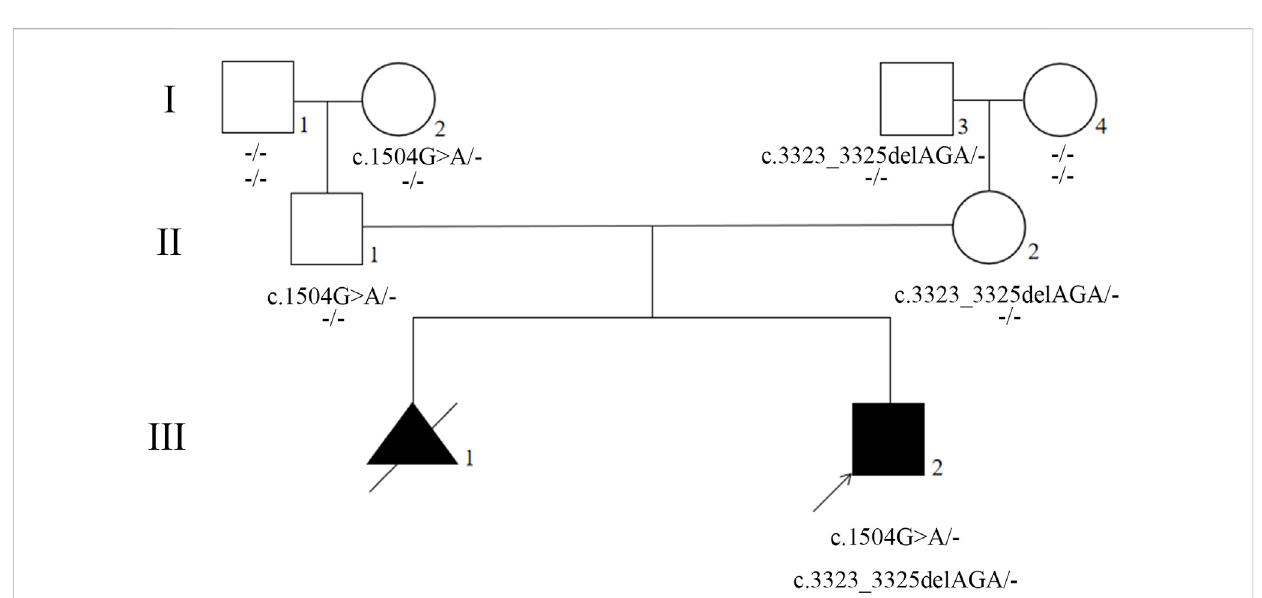
FIGURE 2 Pedigree of the proband ’ s family. Generations are shown as I – III. Squares indicate male, and circles indicate female. Empty symbols indicate unaffected individuals and fi lled symbols indicate affected individuals. Deceased individuals are indicated by a slash (/), the arrow shows the